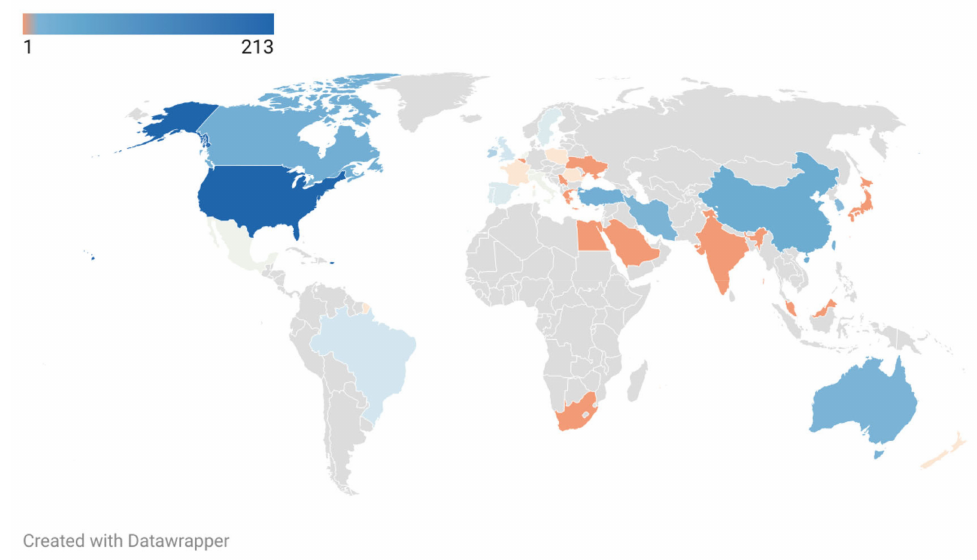
Figure 6. Geographical distribution of PA research in ASD